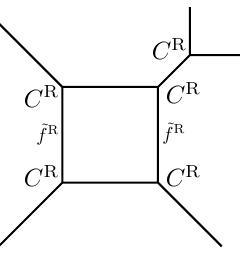
Figure 19 . Reflected 5-brane configuration for a D 4 -type quiver theory discussed in figure 17.